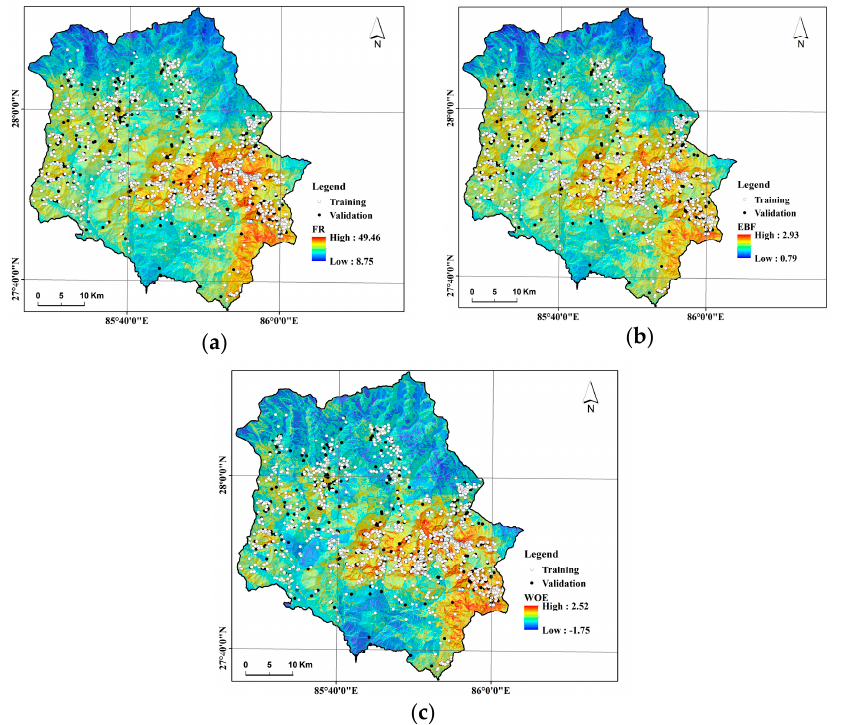
Figure 11. Landslide susceptibility index: ( a ) FR model; ( b ) evidential belief function (EBF) (Bel) model; ( c ) weight of evidence (WOE) model.